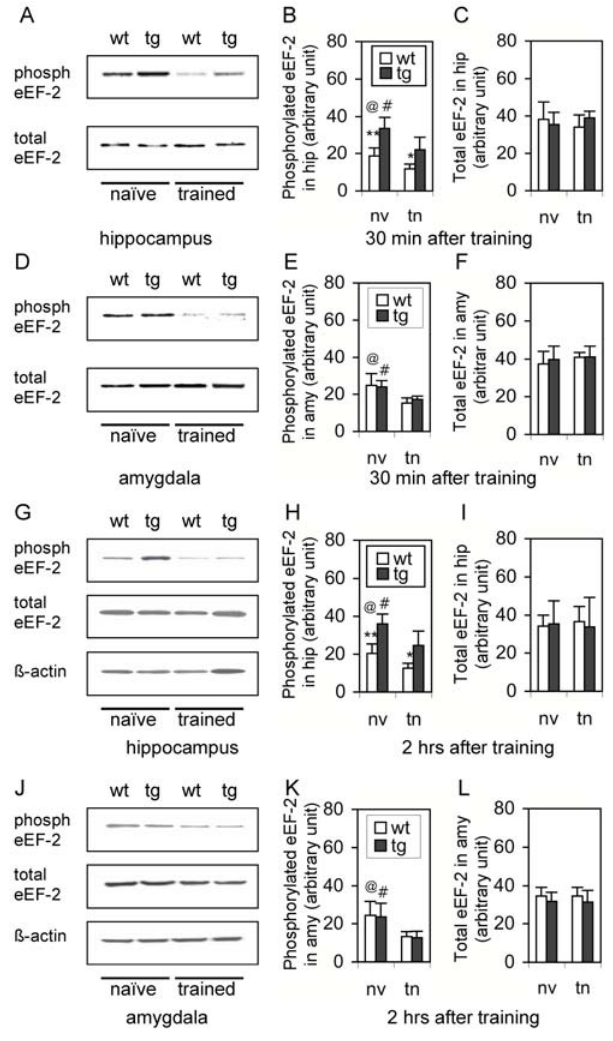
Figure 6. Overexpression of eEF-2K in the hippocampus prevented post-training dephospho-eEF-2. A-F . Expression of phospho-e-EF-2 in mice 30 min after the training. A . Representative Western blots showing the expression level of phospho-eEF-2 (phosph; upper panel) and total eEF-2 (low panel) in the hippocampi from wild- type (wt) and hip-eEF-2K-tg (tg) mice 30 min after training (trained) or without training (naı¨ve). B . Quantitative analysis of the expression level of phospho-eEF-2 in hippocampi 30 min after the training. **, p ,